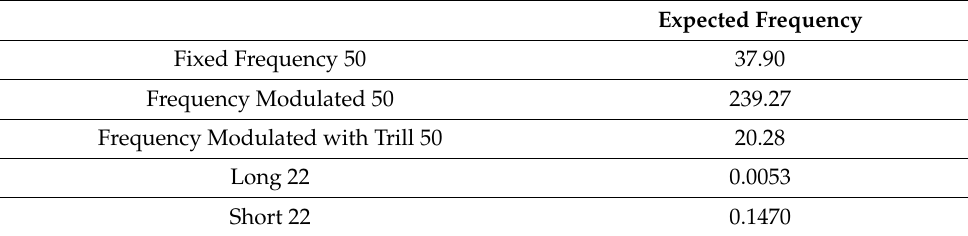
Table A2. Expected frequencies calculated from confusion matrix in Table